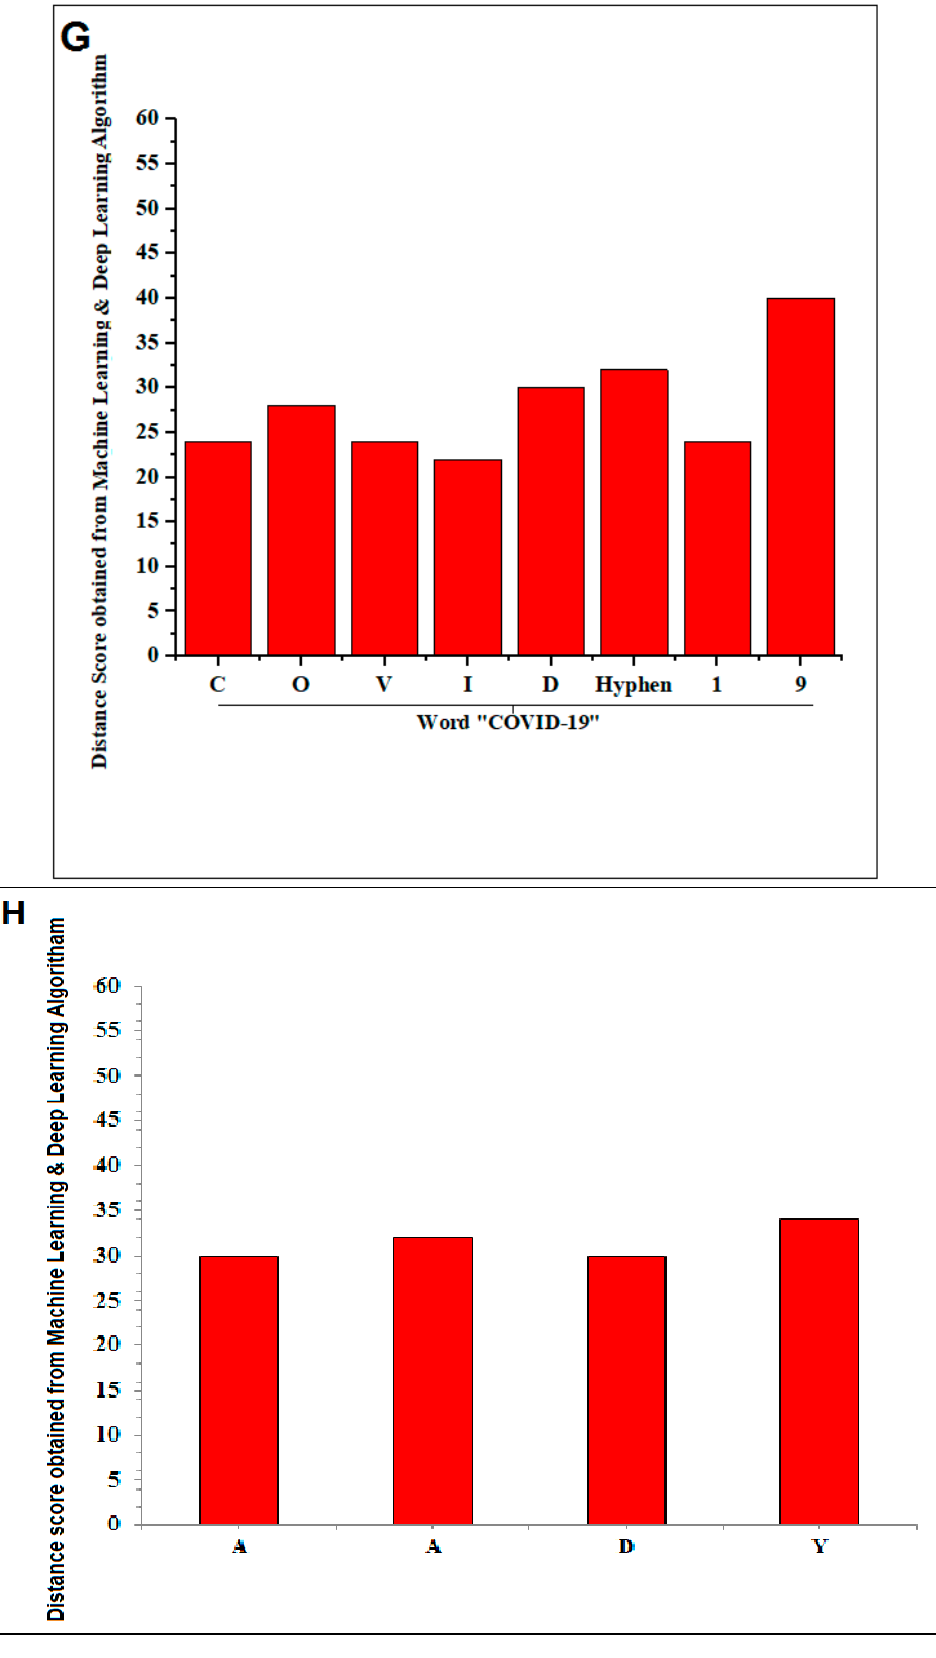
Figure 2. The representation shows the created two words with SARS-CoV-2 proteins and two slogans with non-SARS CoV-2 proteins. ( A ) The diagram shows the created word of “SARS-CoV-2” using protein alphabets. ( B ) The diagram shows the created word of “COVID-19,” using protein alphabets. ( C ) The diagram shows the developed first slogan, “VACCINATE THE WHOLE WORLD WITH COVID-19 VACCINE,” using protein alphabets. ( D ) The diagram shows the developed second slogan, “SAY NO TO SARS-CoV-2,” using protein alphabets. ( E ) The sche- matic diagram shows the process of image comparison and distance score generation. ( F ) Graphical representation of the generated distance score of each protein alphabet of “SARS-CoV-2”. ( G ) Graphical representation of the generated distance score of each protein alphabet of “COVID-19”. ( H ) Graphical representation of the generated distance score of each protein alphabet of four SARS-CoV-2 protein alphabets with antibodies/immunological or vaccine-associated roles. The analysis tried to create the pattern of protein structure and compute the image similari- ty/dissimilarity of 3D structures of each protein. Two slogans using the diversified 3D structures of proteins as alphabets were in- cluded. The PDB was searched extensively to derive different protein alphabets from SARS-CoV-2 and non-SARS-CoV-2. Finally, two slogans were generated using the pro- tein alphabets: the first was titled, “VACCINATE THE WHOLE WORLD WITH COVID-19 VACCINE” (Figure 2C), and all proteins as alphabets and their PDB IDs are noted in Table S3; the second was titled, “SAY NO TO SARS-CoV-2” (Figure 2D), and all proteins as alphabets and their PDB IDs are as noted in Table S4. This study fetched the 12-number SARS-CoV-2 proteins and the 14-number non-SARS-CoV-2 proteins to design the words and slogans. Again, the 12-number SARS-CoV-2 proteins alphabet was compared with the English alphabets, and a distance score was generated after image comparison. The lists between the protein alphabets and English alphabets for “SARS-CoV-2” and “COVID-19” are recorded in Tables S5 and S6, respectively. The concept of distance score generation is shown in Figure 2E. The distance